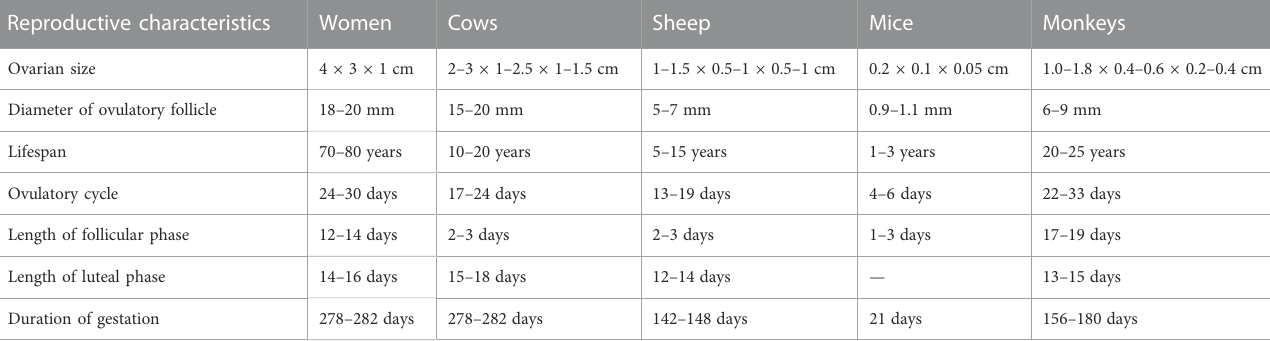
TABLE 1 Reproductive characteristics of humans and some animals. Table content was compiled from Abedal-Majed and Cupp (2019), Lu et al. (2022). Reproductive